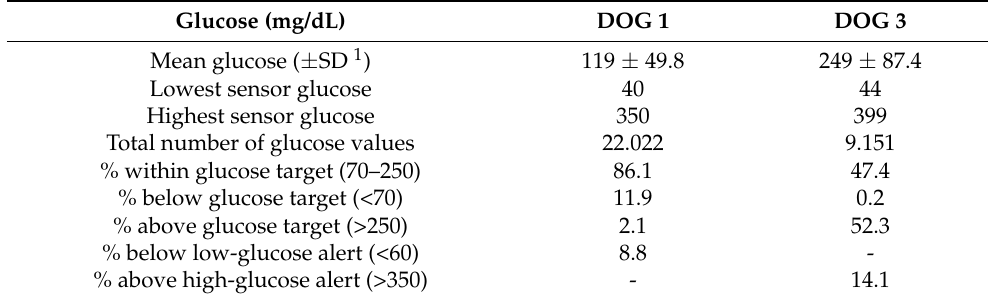
Table 1. Glucose data in two dogs with diabetes mellitus at the end of the sensor wearing period (180